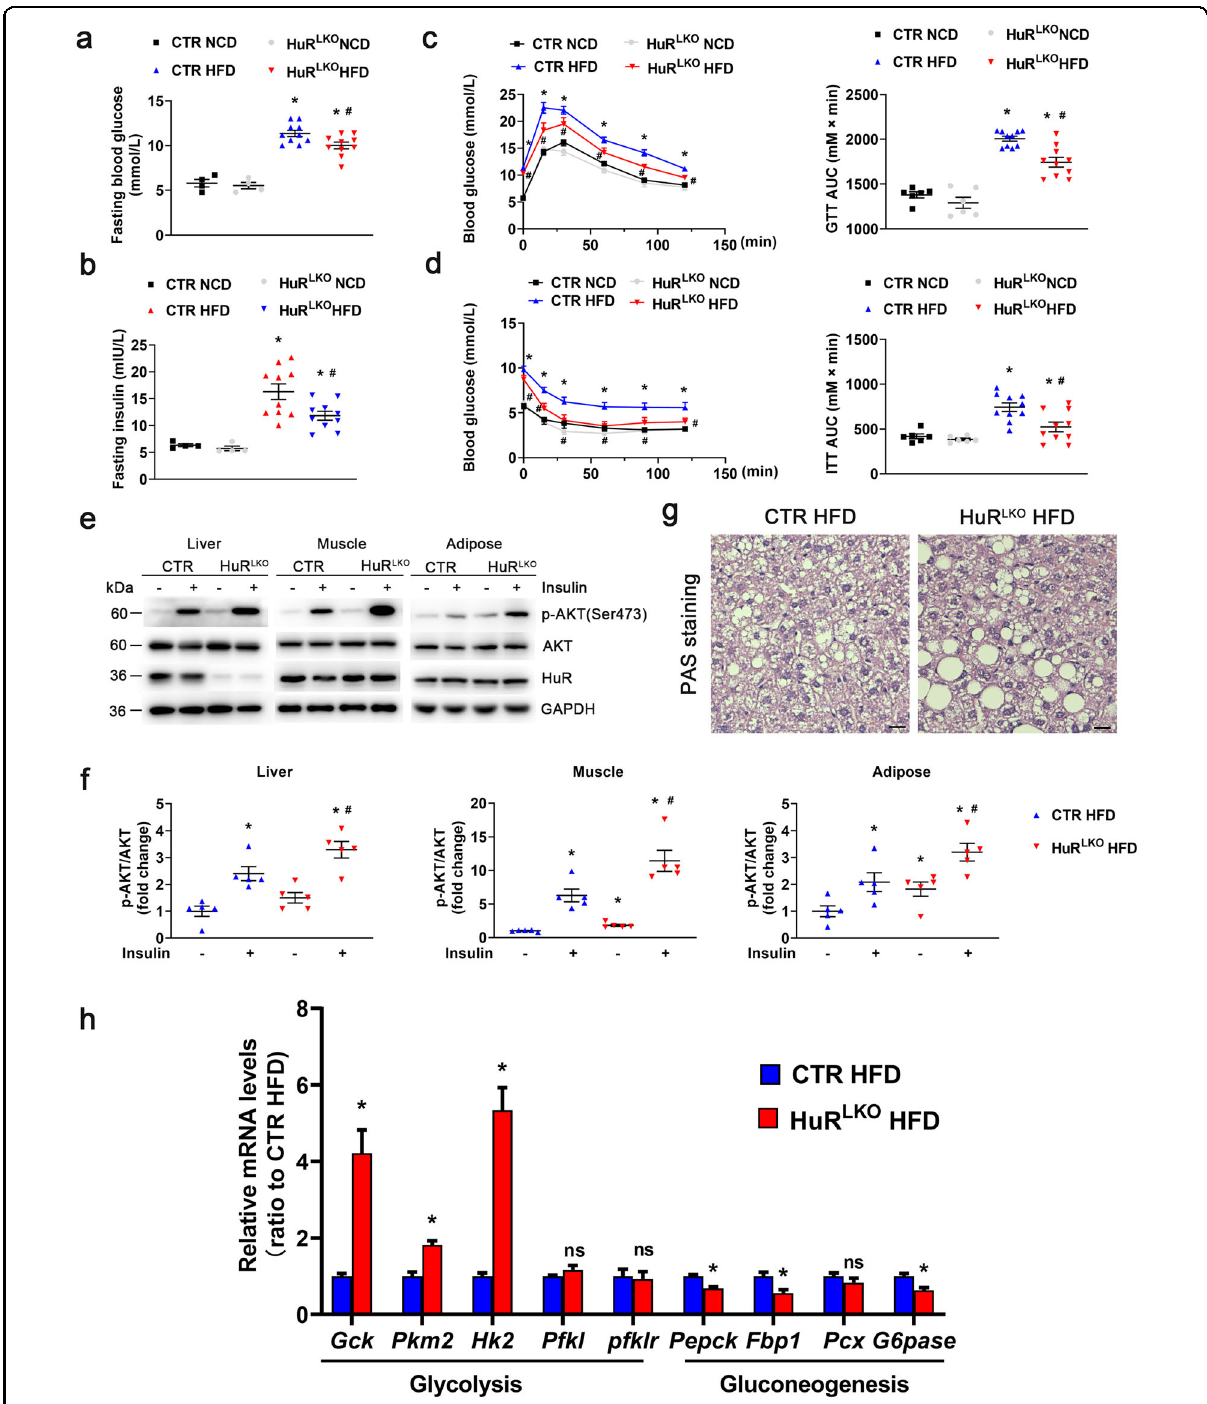
Fig. 3 Liver-speci fi c HuR deletion alleviated HFD-impaired glucose tolerance. Fasting glucose levels ( a ) and fasting insulin levels ( b ) of HuR LKO and CTR mice in response to HFD ( n = 10). * P < 0.05 vs CTR NCD, # P < 0.05 vs CTR HFD. Glucose tolerance test ( c ) and insulin tolerance test ( d ) in HuR LKO and CTR mice after NCD or HFD for 24 weeks. The corresponding areas under the curve (AUC) of blood glucose levels (right) ( n = 8). * P < 0.05 vs CTR NCD, # P < 0.05 vs CTR HFD. e , f Western blot analysis of AKT phosphorylation in tissues of control and HuR LKO mice on HFD ( n = 5). * P < 0.05 vs CTR HFD saline, # P < 0.05 vs CTR HFD insulin. g Periodic acid-Schiff-stained liver sections from HuR LKO and CTR mice after HFD feeding for 24 weeks. Scale bar, 20 μ m. h Relative mRNA levels of genes involved in hepatic glycolysis and gluconeogenesis in HuR LKO and CTR mice on HFD ( n = 5). * P < 0.05 vs CTR